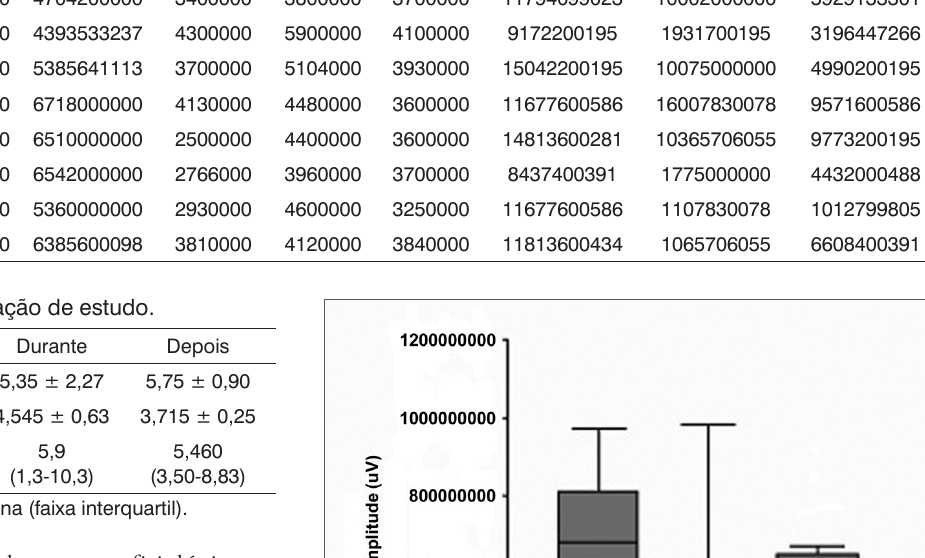
A perda de intensidade da resposta fisiológica ao estímulo inicial de 82 dB após o procedimento foi de 11,8